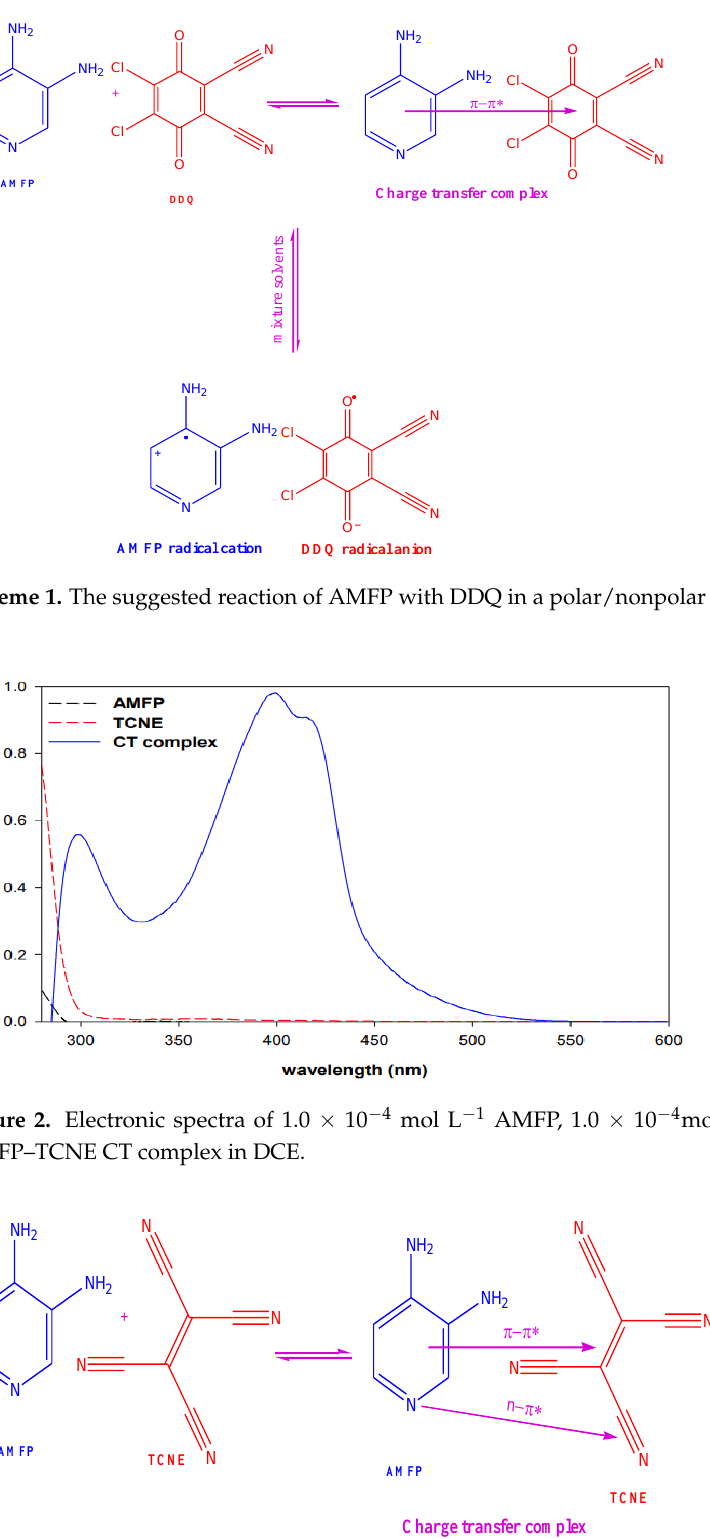
Scheme 1. The suggested reaction of AMFP with DDQ in a polar/nonpolar mixture system.